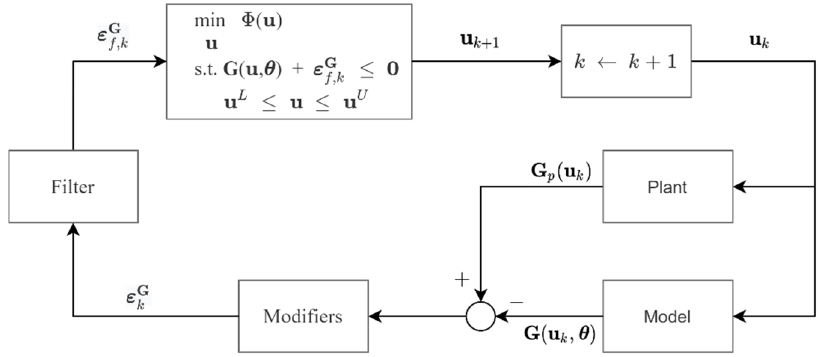
Figure 3. Block diagram of the CA algorithm.